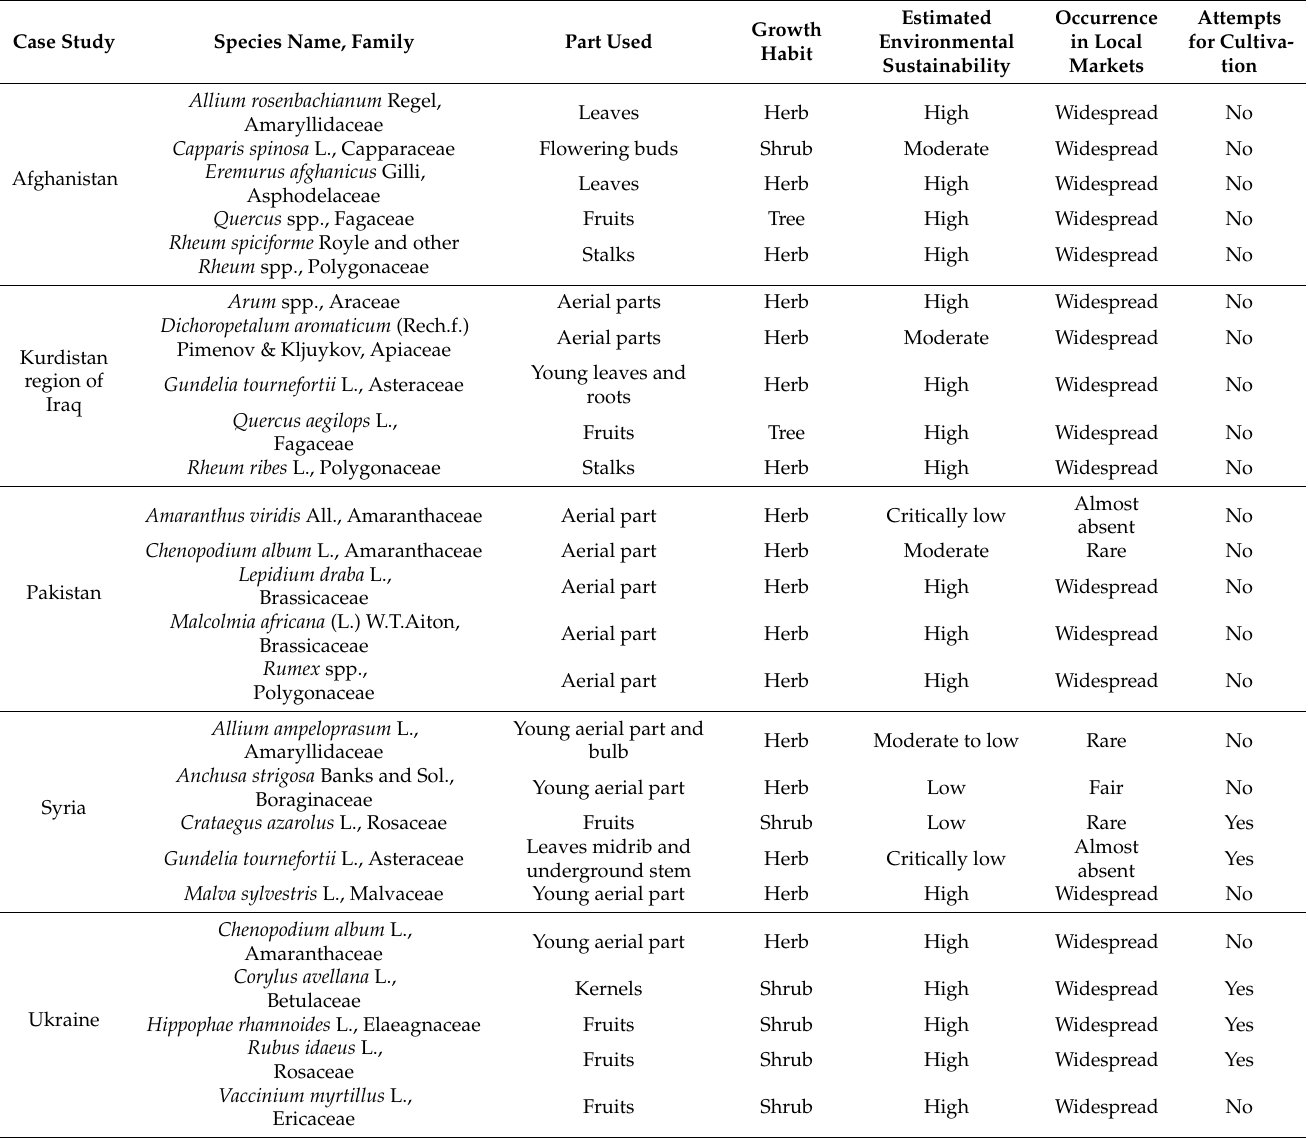
Table 2. Top culturally salient WFPs holding potential for domestication in five conflict-affected contexts across Asia and Eastern